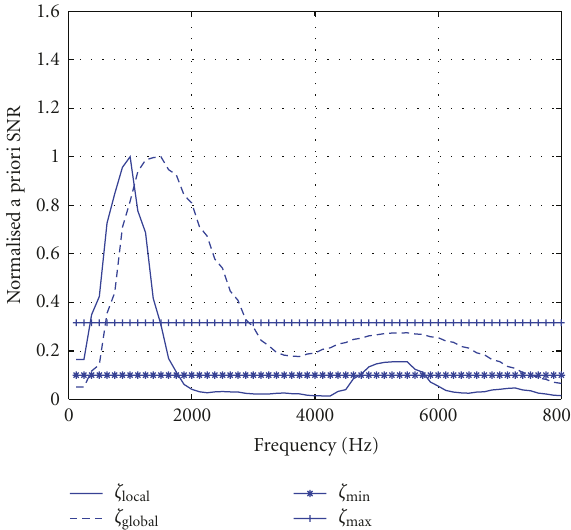
Figure 3: Local and global averaging of the a priori SNR for a given frame. Example of a high a priori SNR at low frequency.